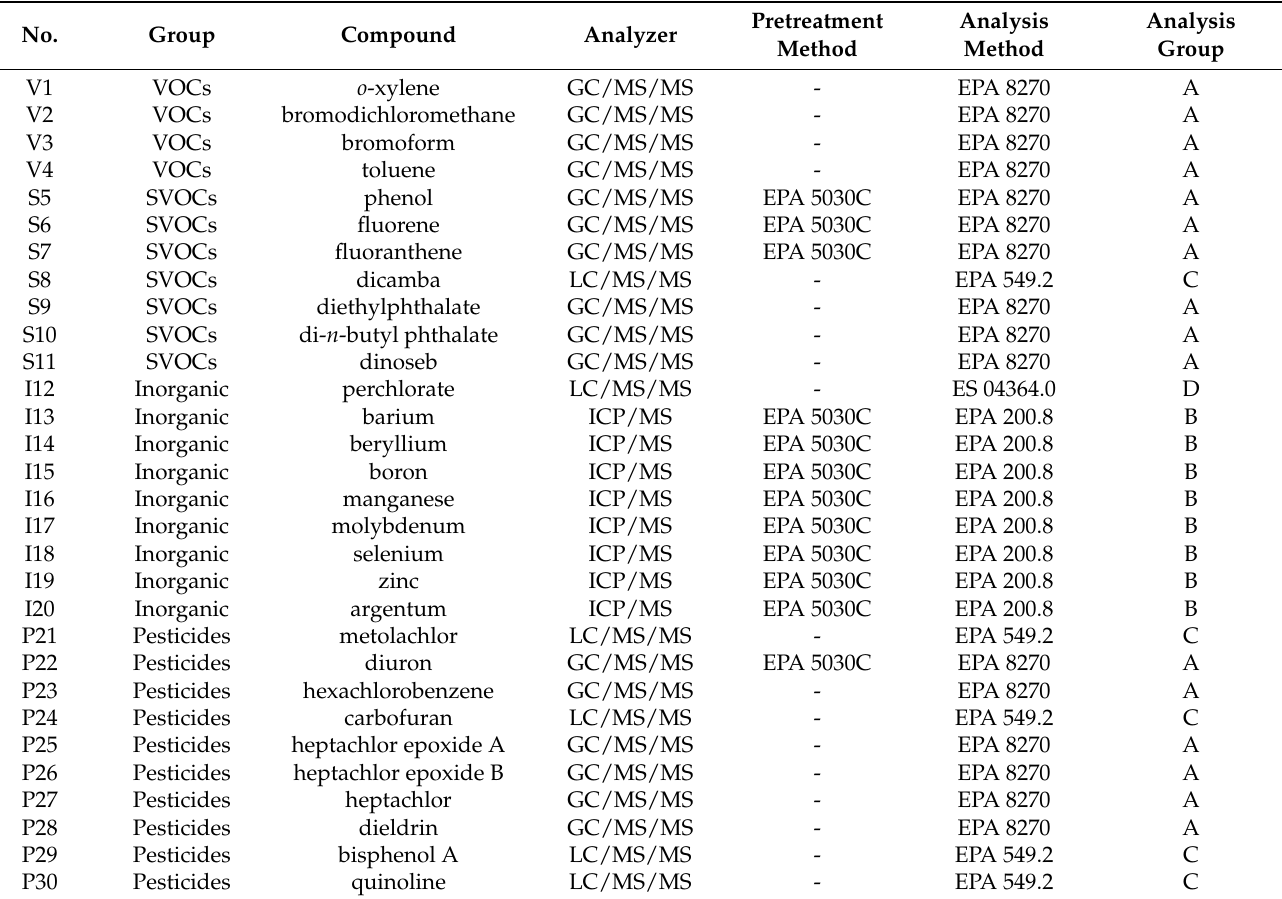
Table 1. Hazardous substance analysis indicators and analysis